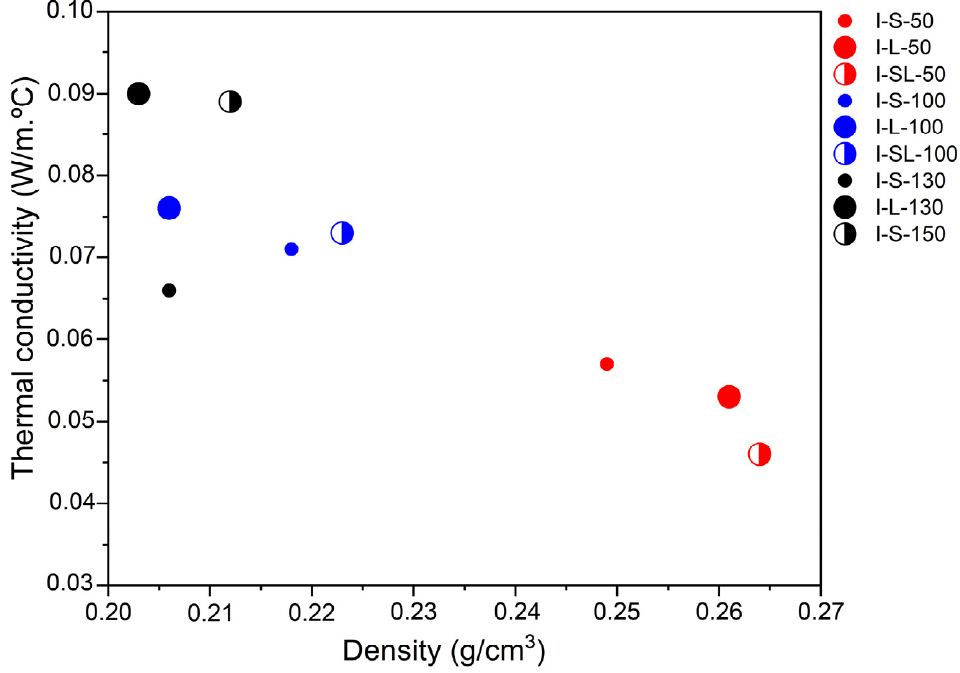
Figure 8. Influence of board thickness and density and diameter of the reeds on the thermal con- ductivity.